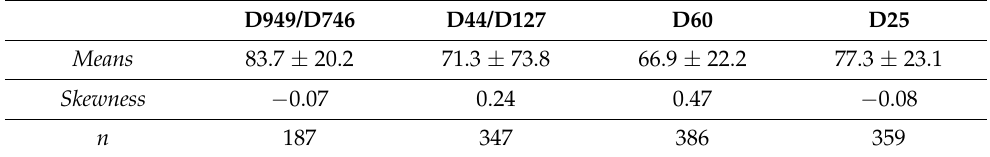
Table 1. Means and standard deviations and skewness distributions of SVLs in the four